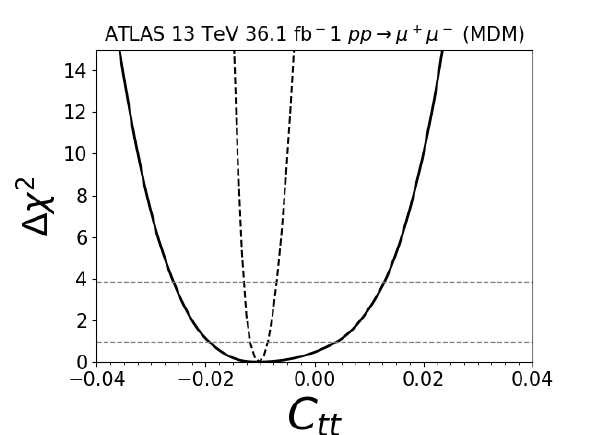
from a (cid:12)t to the ATLAS Z 0